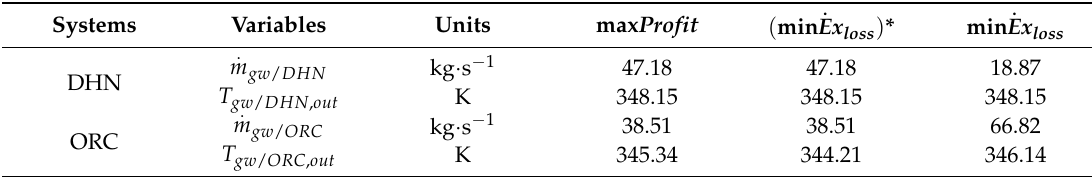
Table 5. Values of geothermal water mass flow rate and its temperature at the outlet of DHN and ORC for the three different studied cases.